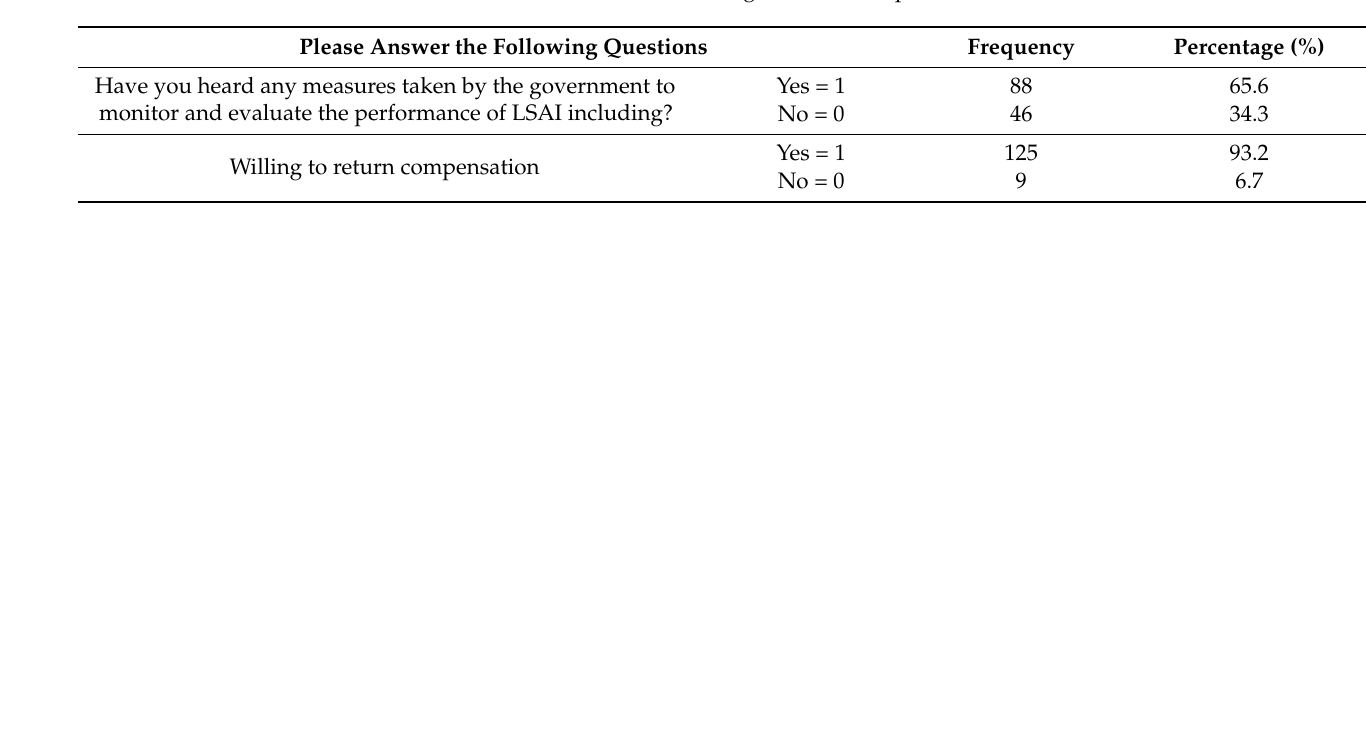
Table A2. Performance, monitoring, and follow-up of the